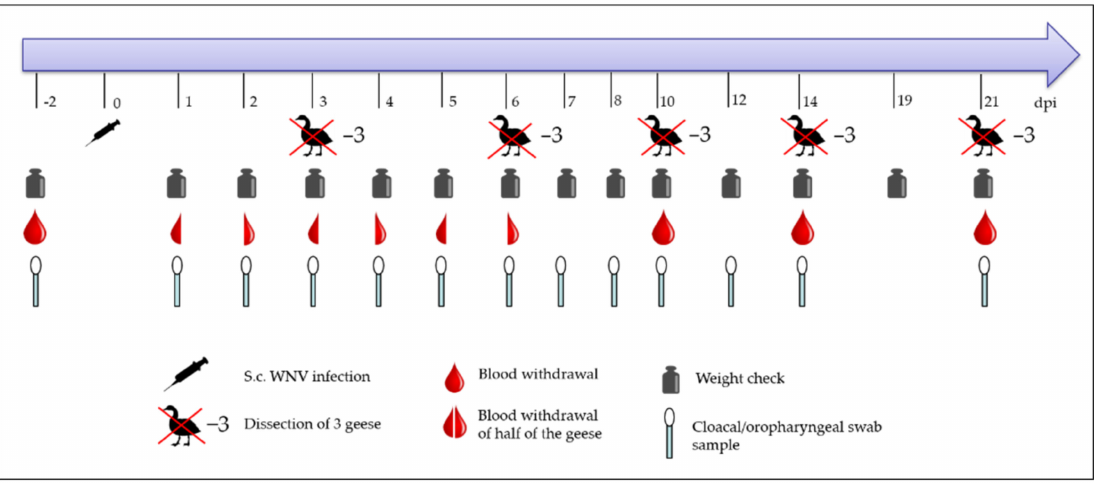
Figure 1. Planned time schedule of the animal experiment, including the sampling procedure over 21